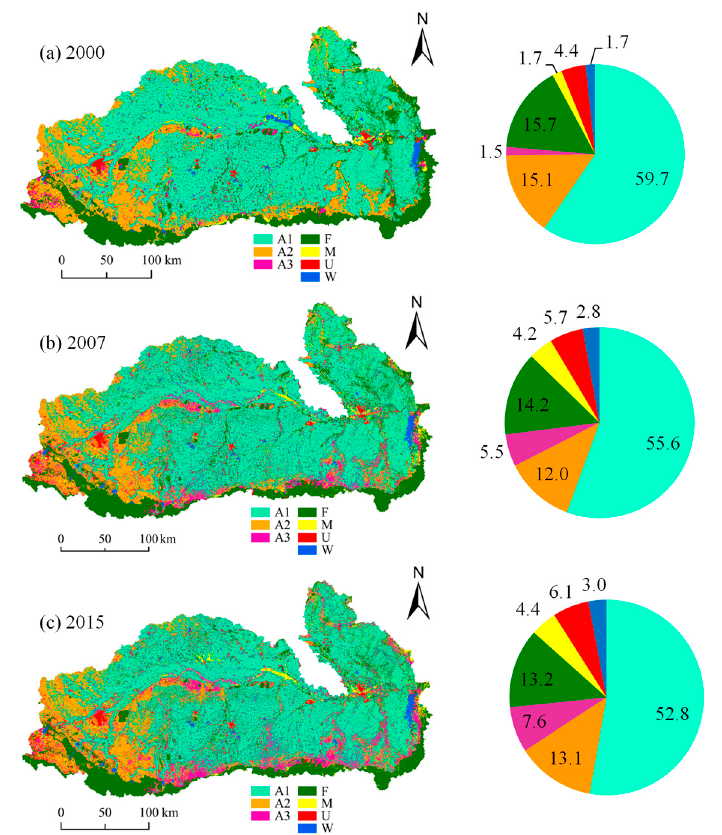
Figure 8. Seven di ff erent land use types (left figure) and the corresponding area proportion (in percentage, right figure) in the Mun River basin in ( a ) 2000, ( b ) 2007, and ( c ) 2015, respectively. A1—paddy field, A2—field crop, A3—other agricultural land (perennial crop, orchard, horticulture,